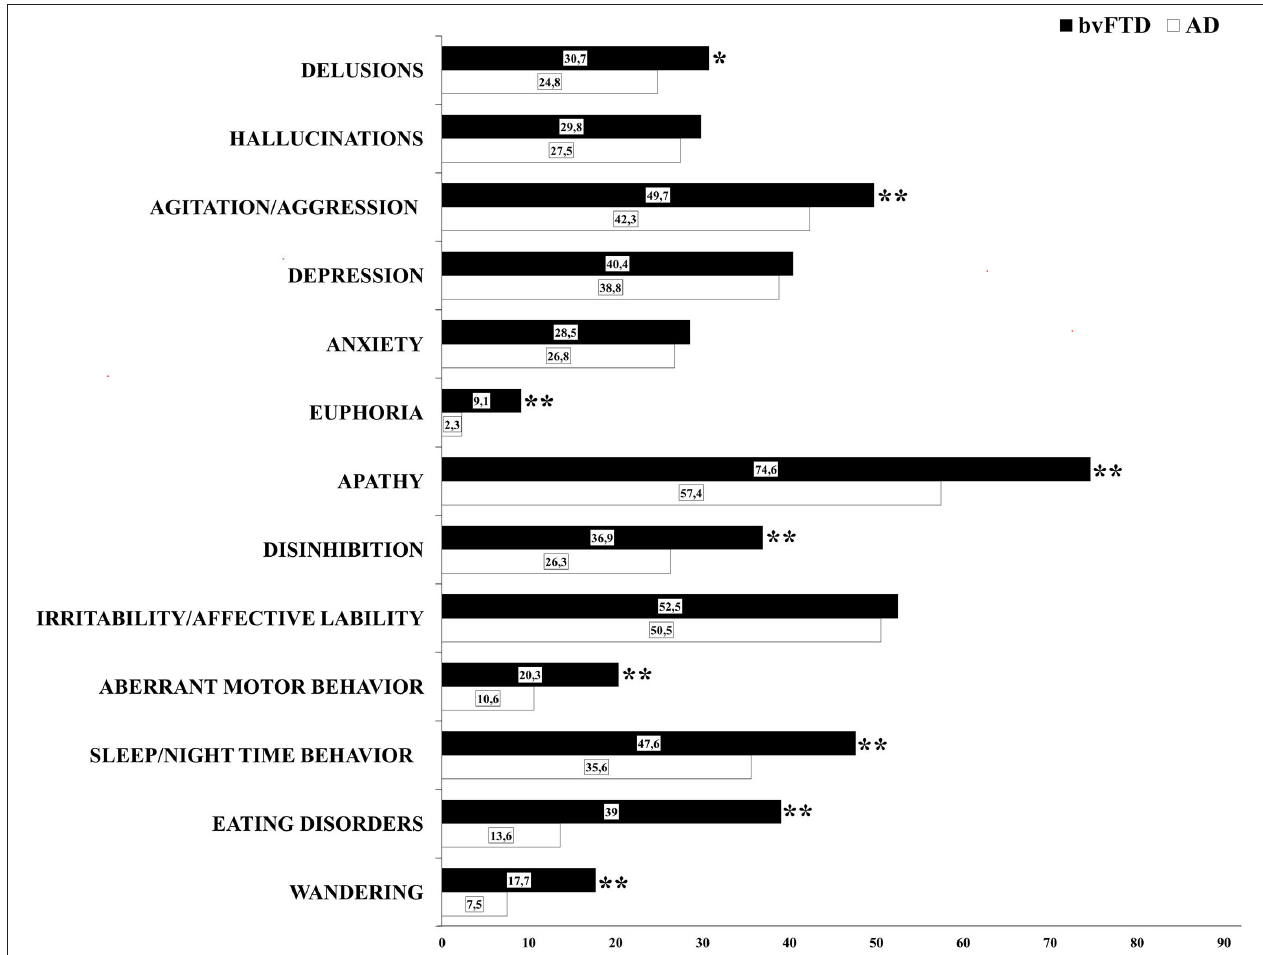
FIGURE 2 | Mean of the year of the BPSD onset in the disease’s history in AD and bvFTD groups. *Significant difference ( p < 0.05). **Significant difference ( p < 0.001).